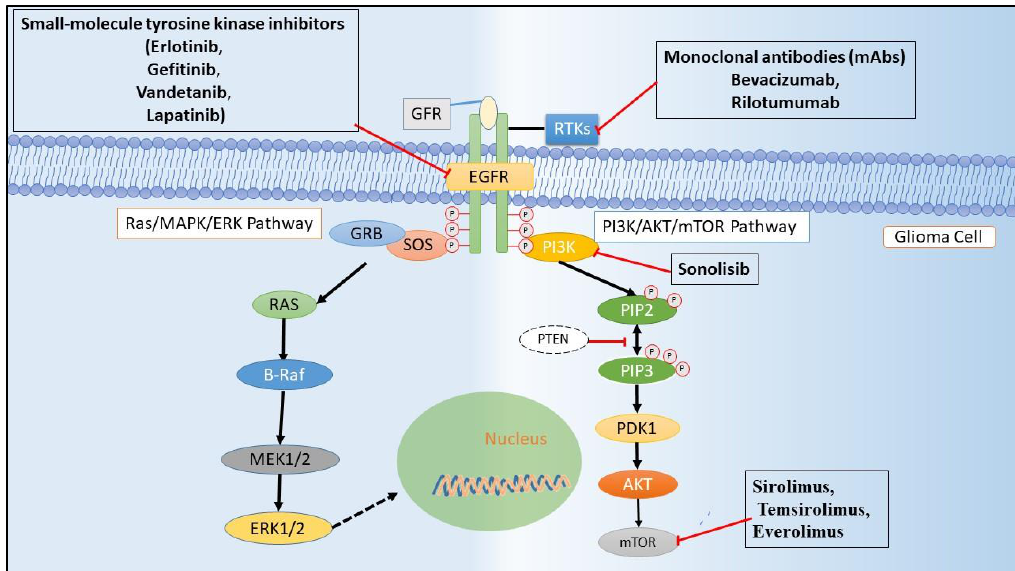
Figure 2. RTKs (EGFR) signal transduction and are a target site for small molecule and monoclonal antibody in glioma treatment. Small-molecule tyrosine kinase inhibitors block the downstream